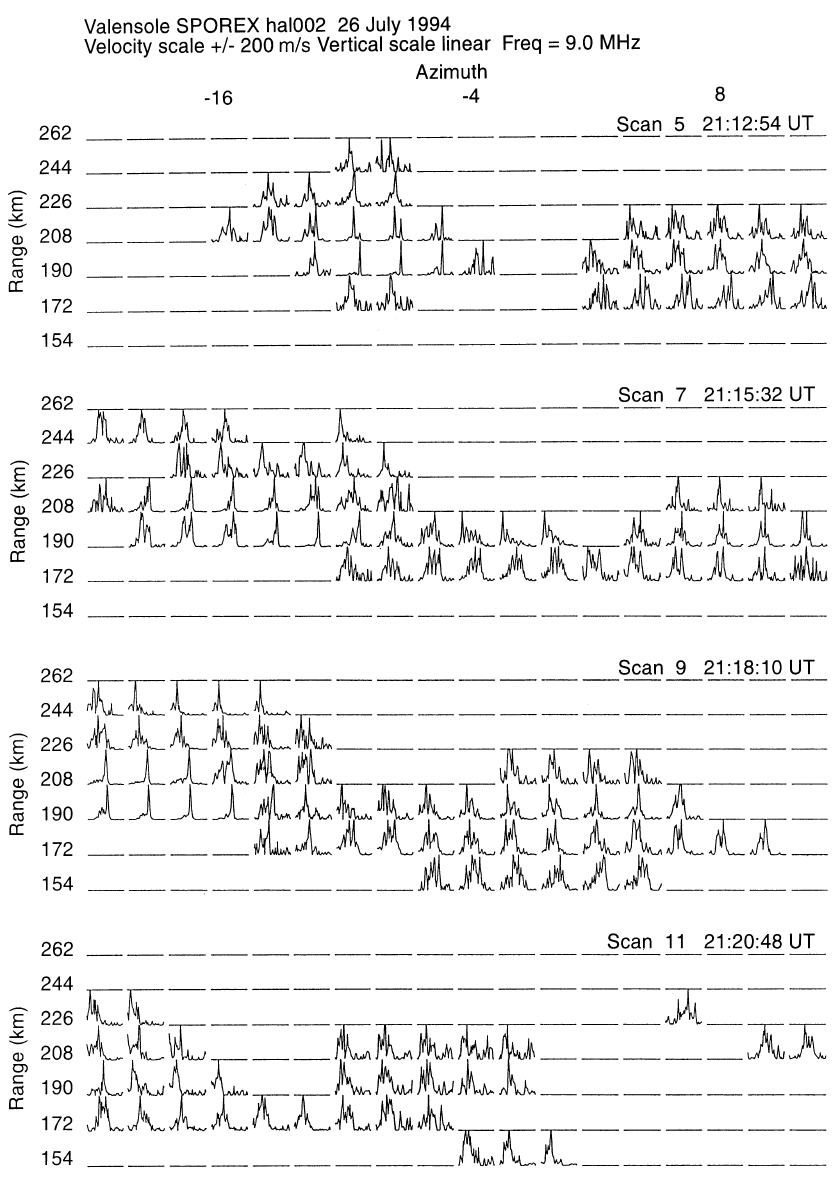
Fig. 2. Four radar azimuthal scans from 22 (cid:176) W to 12 (cid:176) E showing E-region magnetic aspect sensitive echoes at 9 MHz. The scans were performed at 2.5-min intervals. The Doppler spectrum for any cell is linear with the Doppler velocity ranging from ) 200 to 200 m/s. Note the sharp spectra, localized to 3 or 4 adjacent beams, which are observed to move westwards at a velocity of